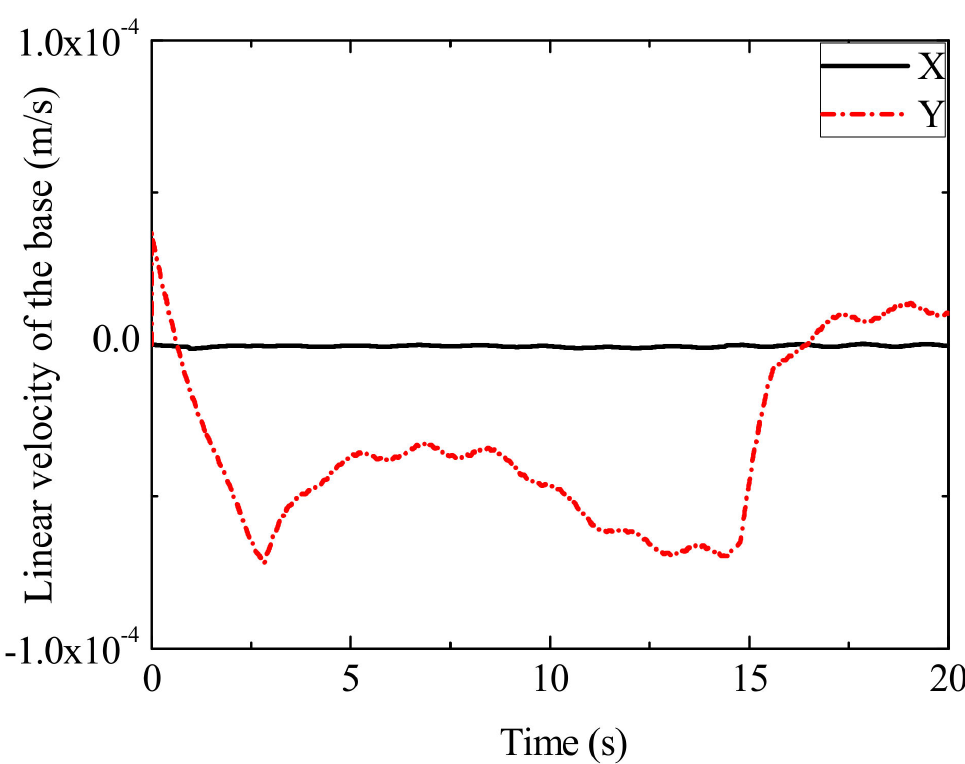
Figure 9. Linear velocity of the base in the preassembly